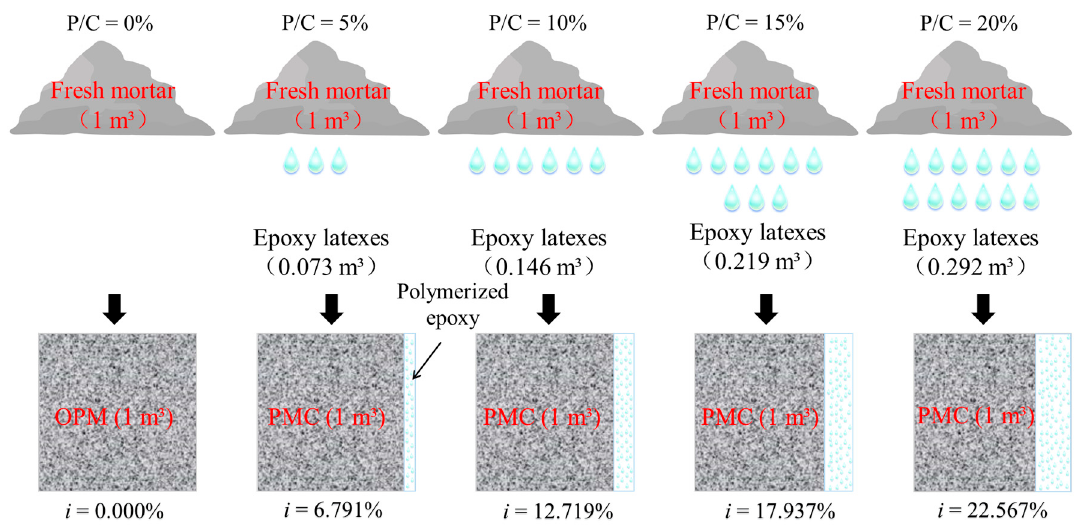
Figure 5. The proportion of cement mortar in the unit volume of epoxy latexes modified mortar. Table 4. Reduction of cement paste in the unit volume of mortar ( i ).